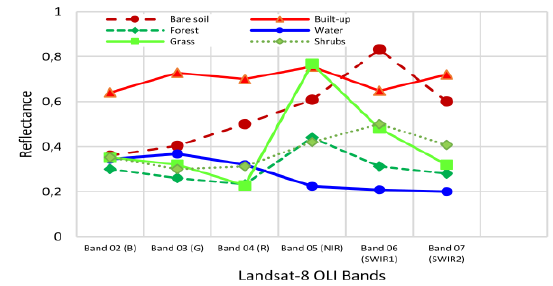
Figure 2. Spectral profiles for urban LULC classes based on the Landsat